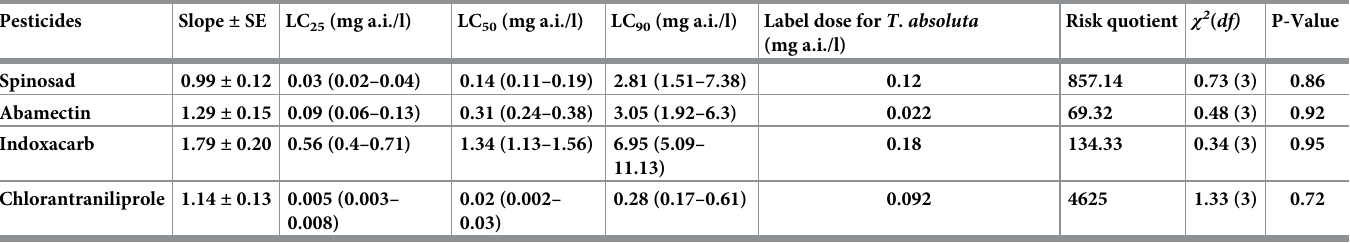
Table 1. Summary of probit analysis results and estimated Lethal Concentrations (LC 50 and LC 90 ) of the chemical insecticides tested on Trichogramma brassicae juvenile stages within Tuta absoluta eggs. Pesticides Slope ± SE LC 25 (mg a.i./l) LC 50 (mg a.i./l) LC 90 (mg a.i./l) Label dose for T . absoluta